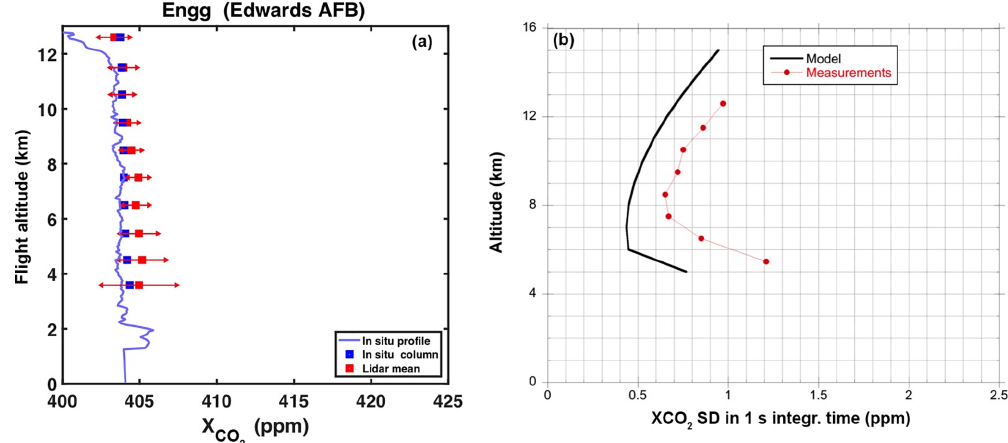
Figure 23. (a) Plot of the measurements made during the spiral-down segment of the 2016 desert flight over the Rogers Dry Lake bed near Edwards AFB, CA. The XCO 2 retrievals from the lidar measurements are shown (in red) from the plotted altitude to the surface, the in situ CO 2 concentration measurements (blue line) and the XCO 2 computed from the in situ CO 2 readings from the plotted altitude to the surface (blue dots). (b) Plot of the SD of the XCO 2 retrievals from the lidar measurements (red) using 1s integration time, showing best resolution near 8km altitude. The solid black line represents the SDs computed from a statistical model of the lidar measurement.